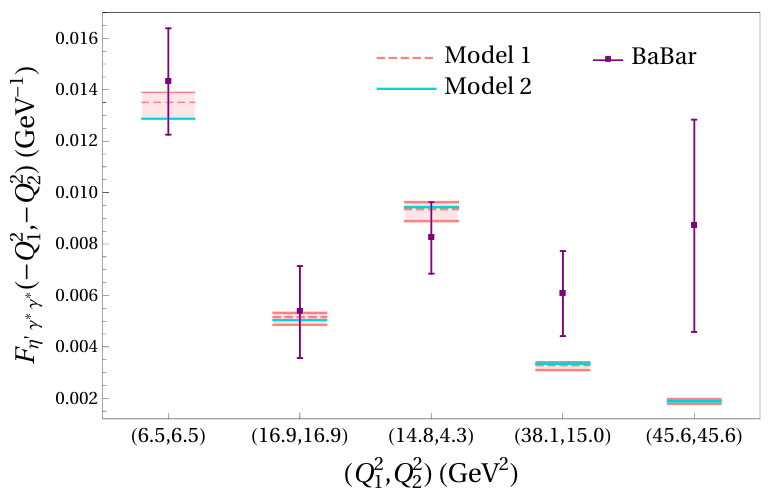
Figure 9. Comparison to the doubly-virtual (cid:17) 0 TFF data from BaBar [122]. The large- N c Regge model, \Model 1" (4.34), is indicated by the pink bands with the dashed lines. Our alternative TFF model, \Model 2" (B.1), is indicated by the solid cyan